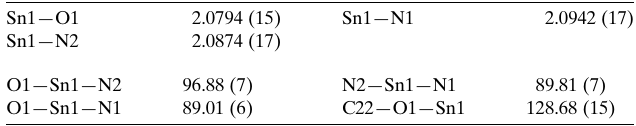
Table 1 Selected geometric parameters (A˚ , (cid:4) ).